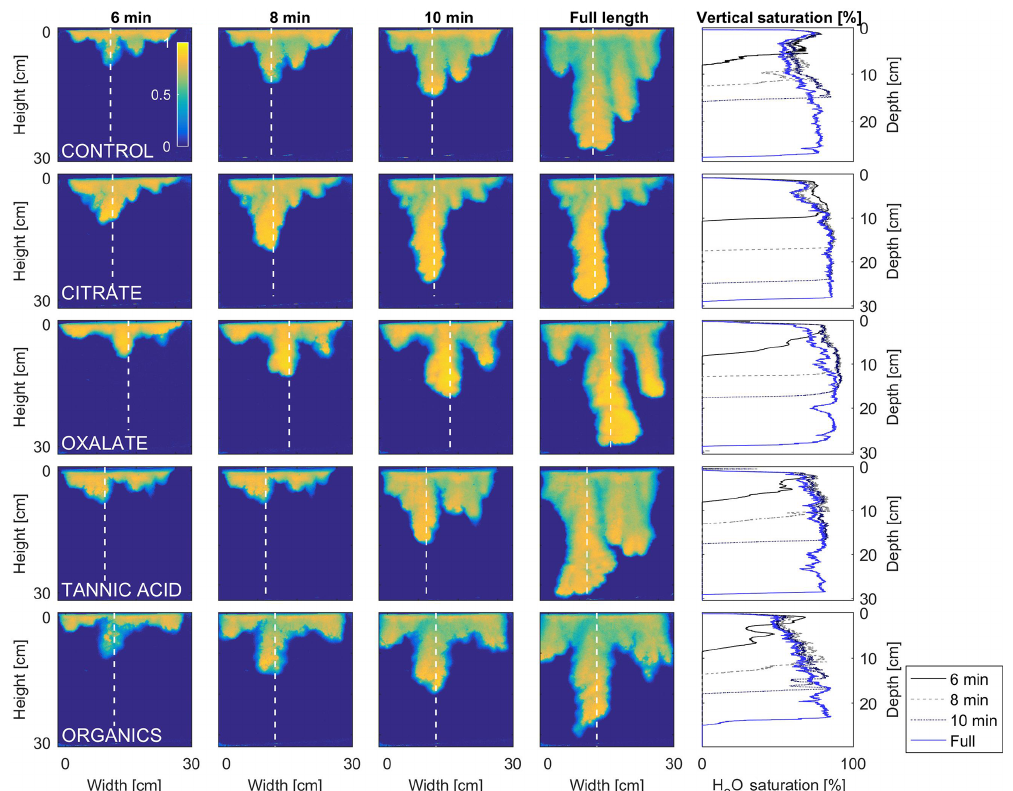
Figure A1. Second tank experiment data set. Multigraph comparison of the dynamic vertical profiles of infiltration of water in US Silica C778 ASTM graded sand for control (NaCl + HNS), and low concentrations of plant exudates (citrate and oxalate) and soil components (tannic acid and organics: Suwanee River natural organic matter, SRNOM). The images are of the main finger and the vertical water saturation profile analysis over